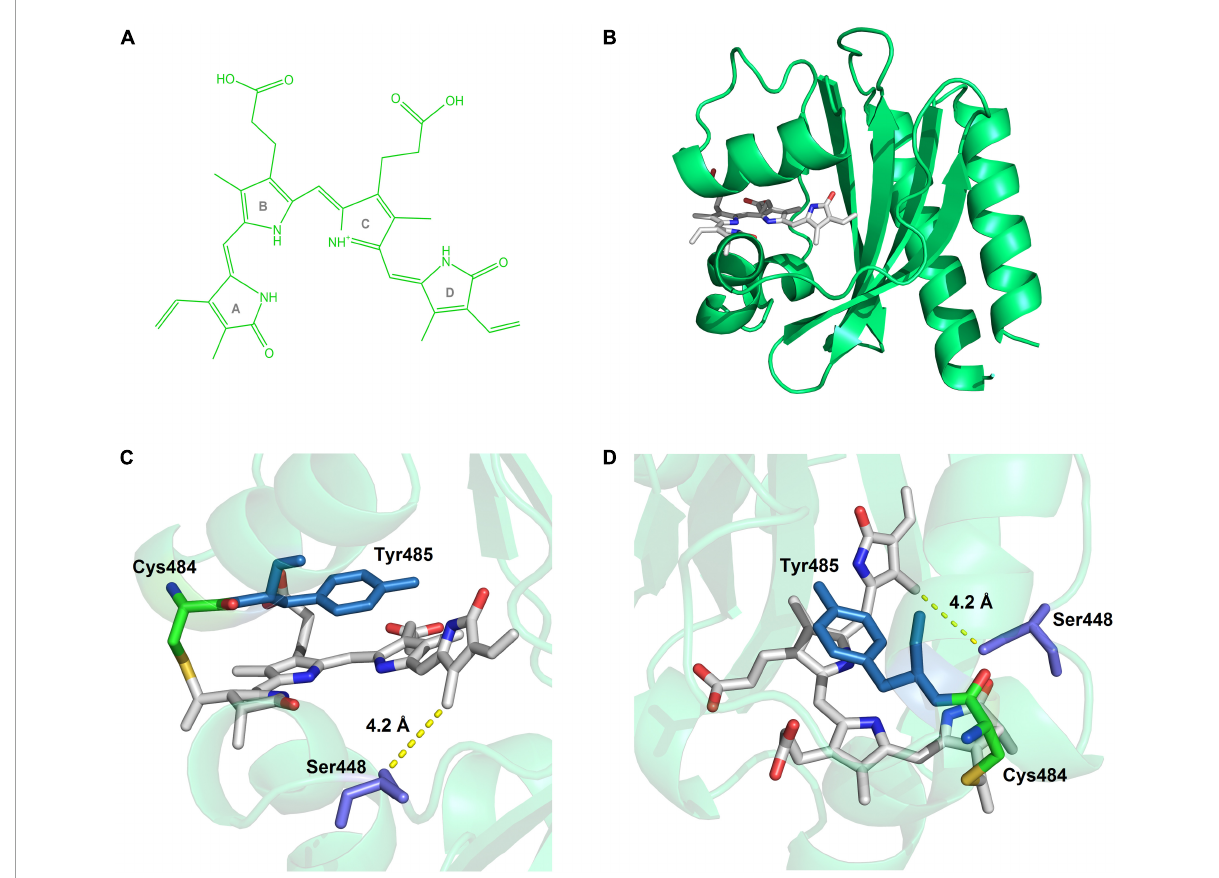
FIGURE6 Simulated structure of C448S_CY. (A) The structure of biliverdin. (B) The overall view of the BV-incorporated C448S_CY. (C) The side view close to the pocket, Ser448 surrounds the D ring of the chromophore, at the closest distance of 4.2 Å. (D) The above view, the benzene ring of Tyr485 is parallel to the